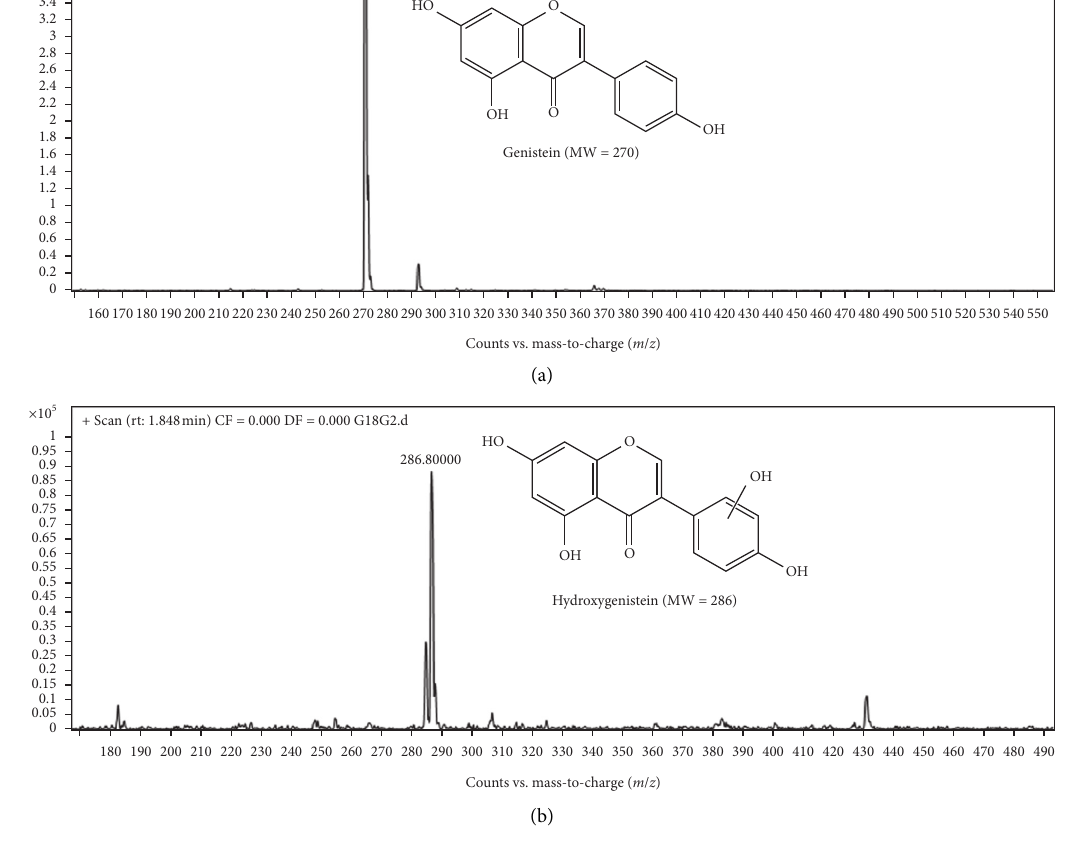
Figure 5: Mass spectra of genistein and its products by Streptomyces species G-18.